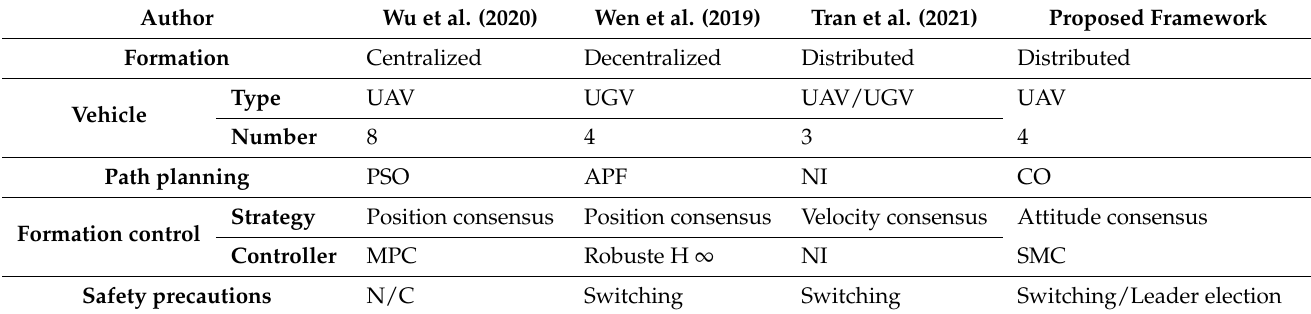
Table 2. Article architecture comparison.